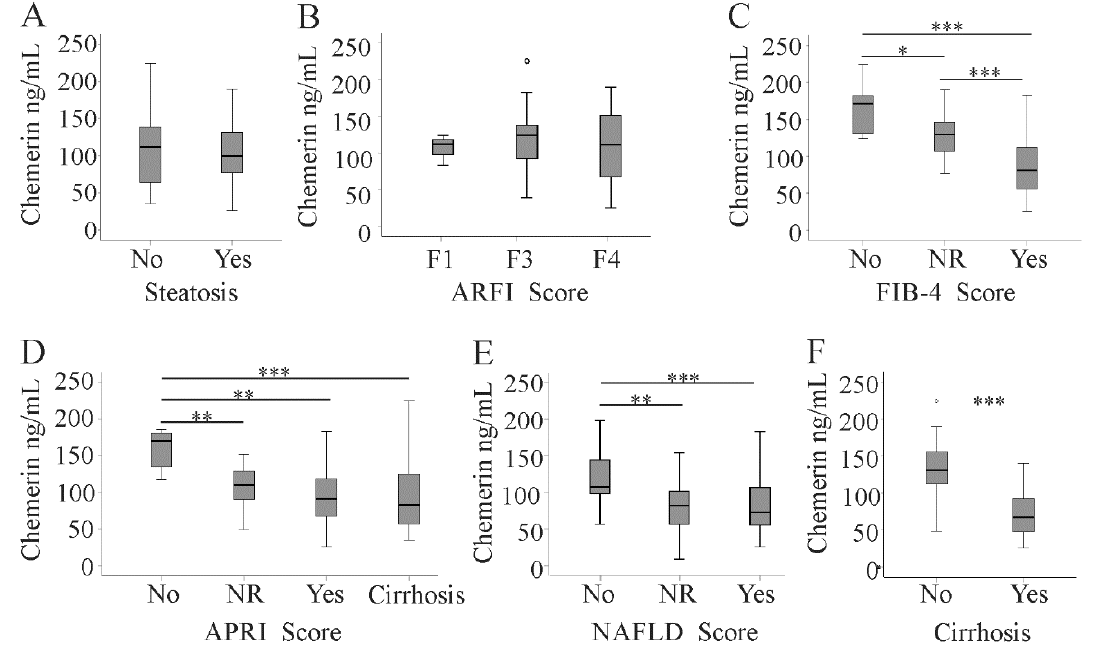
Figure 3. Serum chemerin in relation to hepatic steatosis and fibrosis scores. ( A ) Chemerin in 37 patients with and 45 patients without liver steatosis; chemerin levels in patients stratified for fibrosis by ( B ) the acoustic radiation force impulse (ARFI) score ( C ), the fibrosis-4 (FIB-4) score, ( D ) the aminotransferase / platelet (AST / PLT) ratio index (APRI) score, and ( E ) the non-alcoholic fatty liver disease (NAFLD) score; ( F ) chemerin in 37 patients with liver cirrhosis and 45 non-cirrhotic patients diagnosed by ultrasound (no fibrosis = no; not reliable values = NR, fibrosis = yes). Small circles above the boxes mark outliers. * p < 0.05, ** p < 0.01, *** p < 0.001.